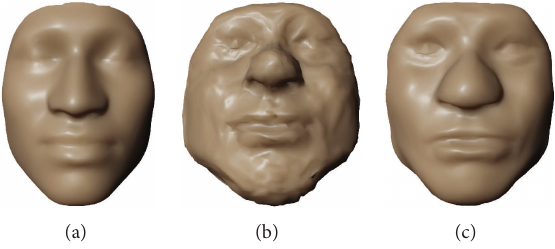
Figure 3: Comparison of different surface representations in blend- ing process by applying random scaling factors to each representa- tion: (a) the original face model, (b) vertex displacement represen- tation, and (c) affine transformation